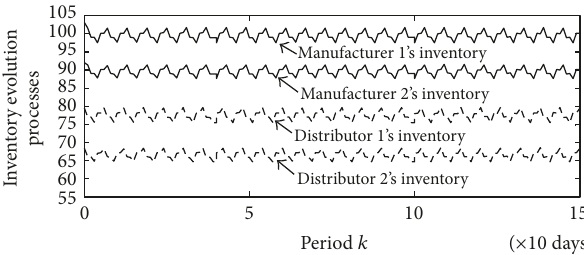
Figure 4: Inventory evolution processes under the common robust strategy ( ×10 4 ton).